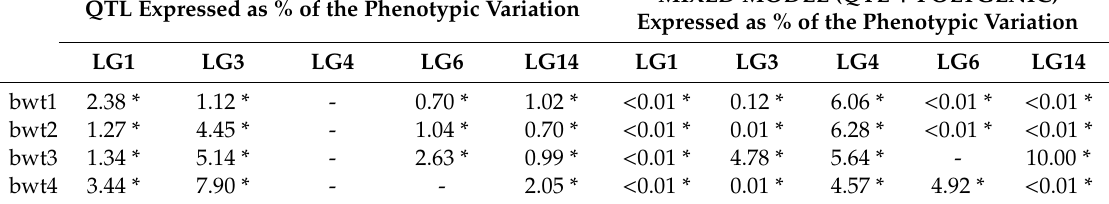
Table 6. Phenotypic variation of all QTLs (QTL heritability) for bodyweight. MIXED MODEL (QTL + POLYGENIC) QTL Expressed as % of the Phenotypic Variation Expressed as % of the Phenotypic Variation LG1 LG3 LG4 LG6 LG14